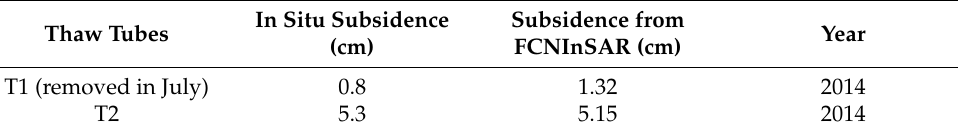
Table 4. Subsidence at the location of thaw tubes.